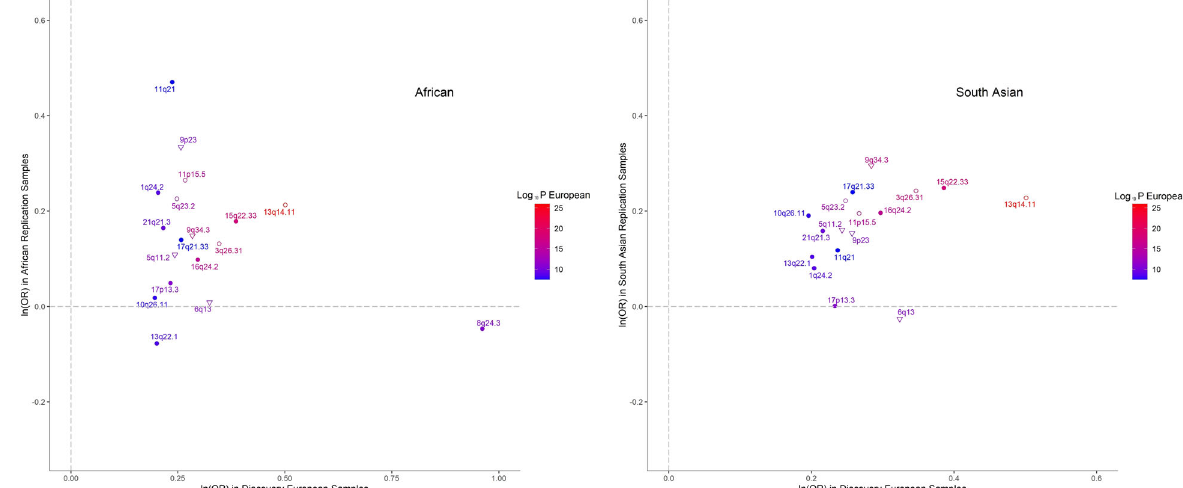
Fig. 2 Comparison of effect sizes of associations for the same SNPs in individuals of African (405 cases and 4185 controls) and South Asian (759 cases and 8009 controls) ancestries. Each dot represents SNPs shown in Supplementary Data 3 and their labels are the respective chromosomal band on which they are located. The shapes of each data point refer to a previous GWAS association with keratoconus (empty circles), with CCT only (empty triangles) or novel associations (solidly fi lled circular shapes). The colors of both the points and their labels represent the signi fi cance ( − log10( p -value) of association observed in the European discovery cohort. Polymorphisms identi fi ed in the discovery cohort but not shown here were not available for analysis in the replication cohorts.